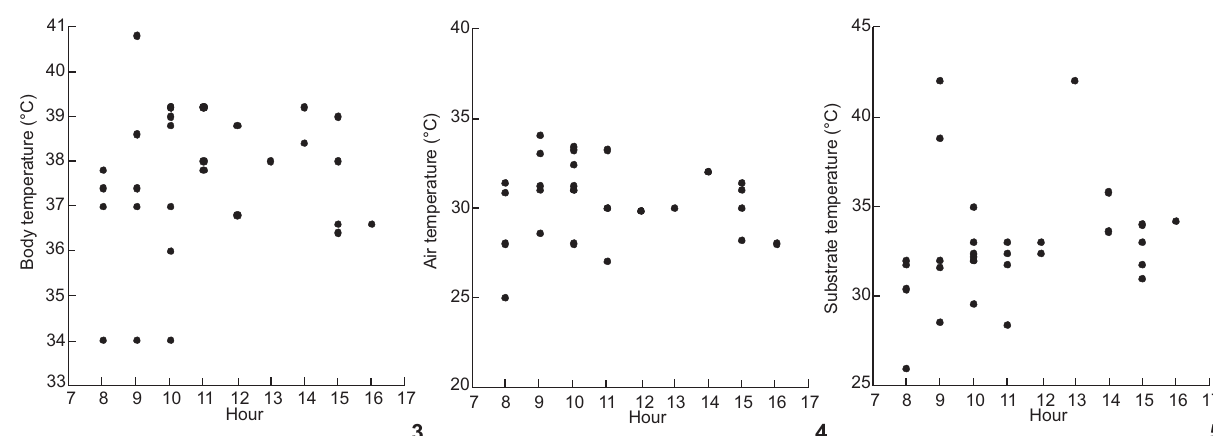
Figures 3-5. Body temperatures recorded during activity of C. ocellifer (3) and air (4) and substrate (5) temperatures (°C) throughout the day in the Morro do Chapéu, Bahia. Dots represent observations in different days.